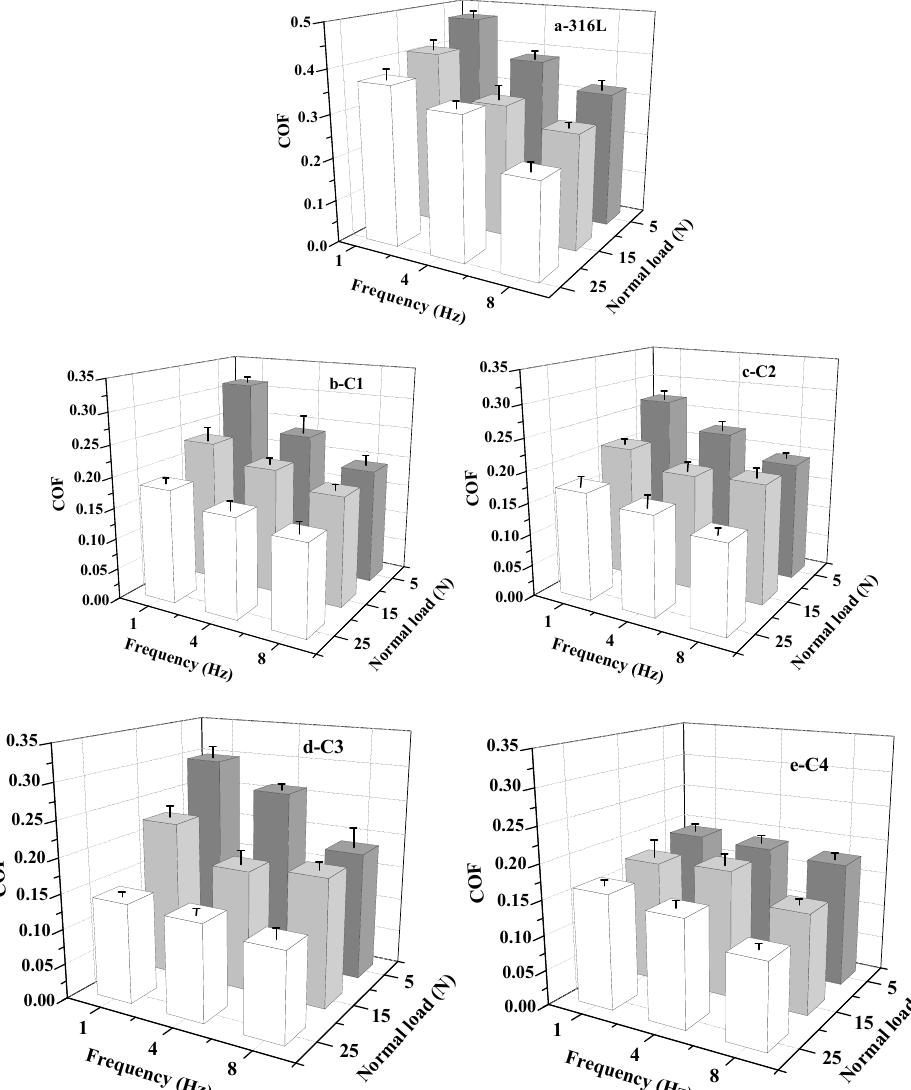
Figure 7. The COF of 316L substrate and CrN films in seawater: ( a ) 316L; ( b ) C1; ( c ) C2; ( d ) C3; ( e ) C4.